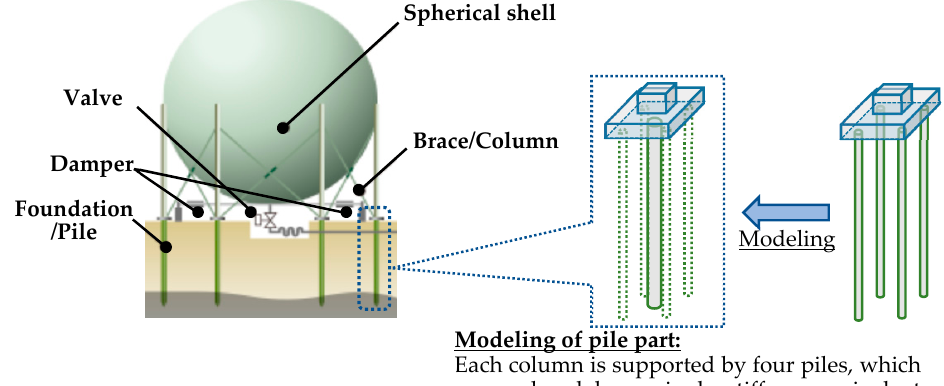
Figure 6. Spherical gas holder (analysis subject). Table 2. Holder specifications.